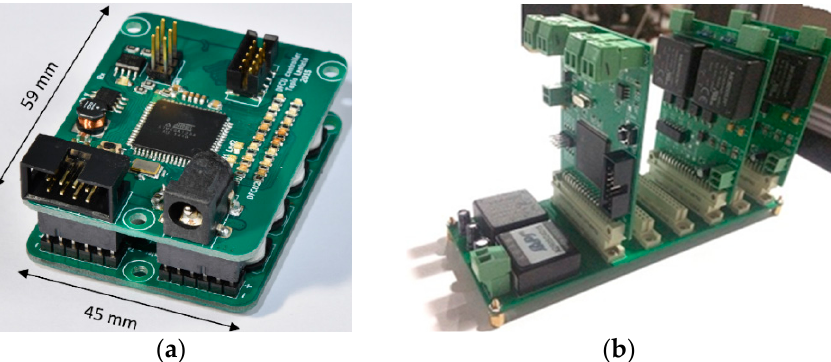
Figure 9. Multi-voltage control circuits: ( a ) control circuit based on the Atmega 128 microcontroller; and ( b ) control circuit based on the DSP TMS28335.